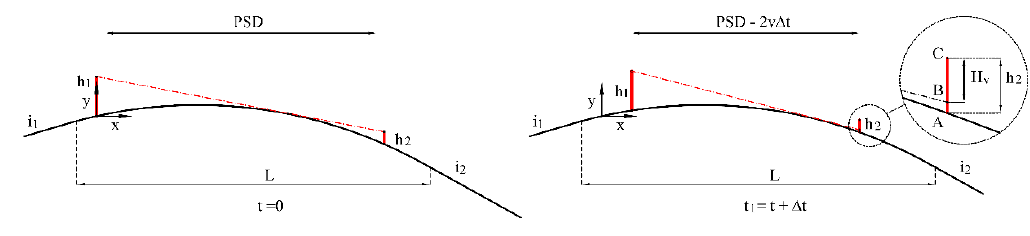
Figure 11. Visible vehicle body height H v.